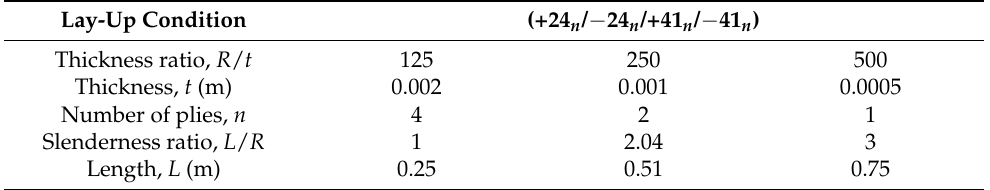
Table 2. Properties of the composite cylinders with various thickness ratios and slenderness